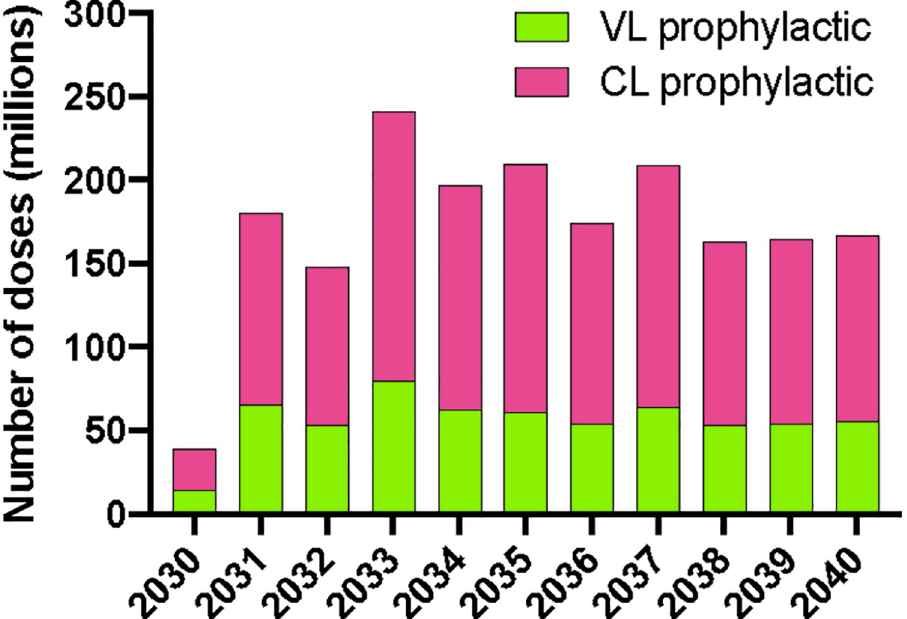
Fig 2. Vaccine demand–total number of yearly doses required at global level for a vaccine with VL and CL indications (details of the methodology provided in S1 Text).